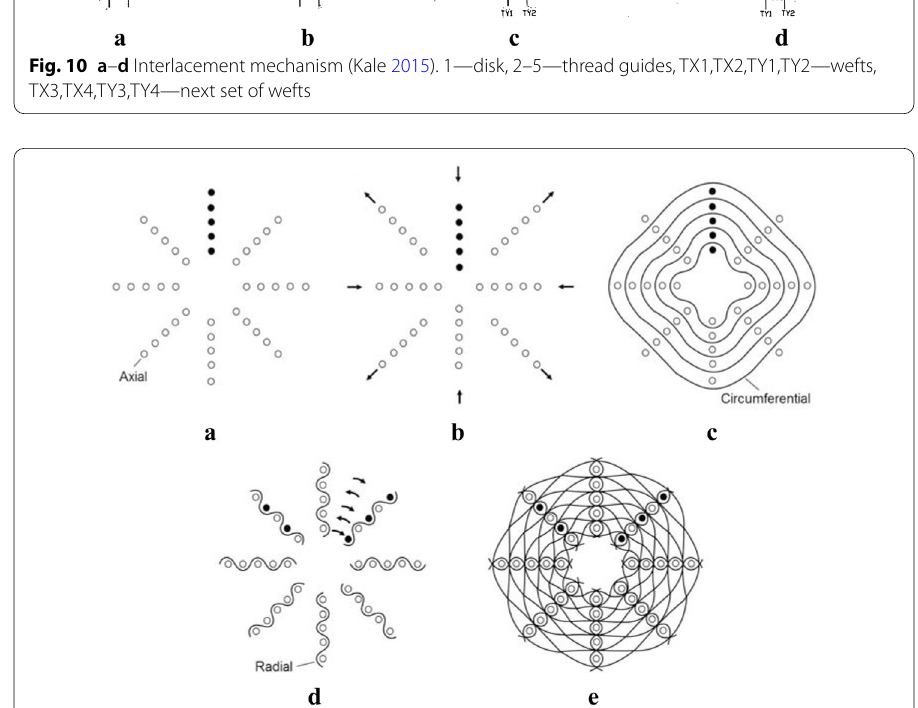
Fig. 11 a – e Shedding sequence in circular 3D fully interlaced preform weaving (Bilisik et al.